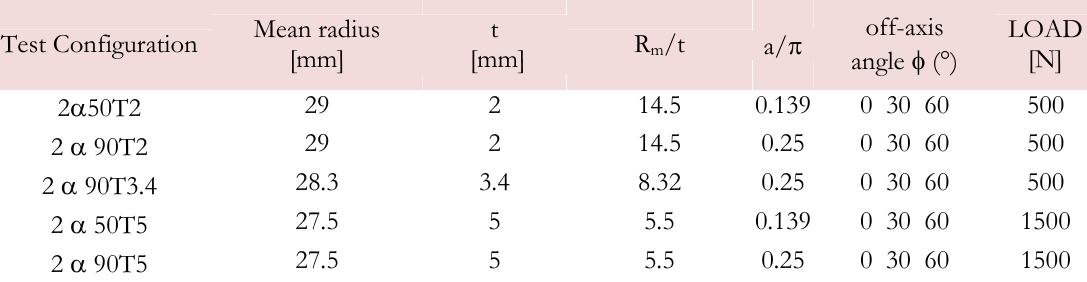
Table 1: Test configuration: three different R m /t and two different crack